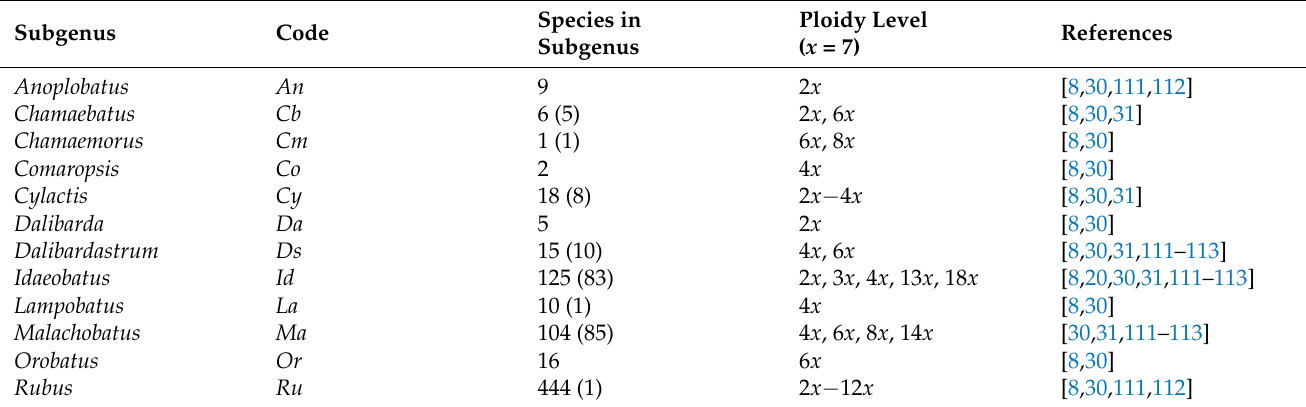
Table 2. List of Rubus L.